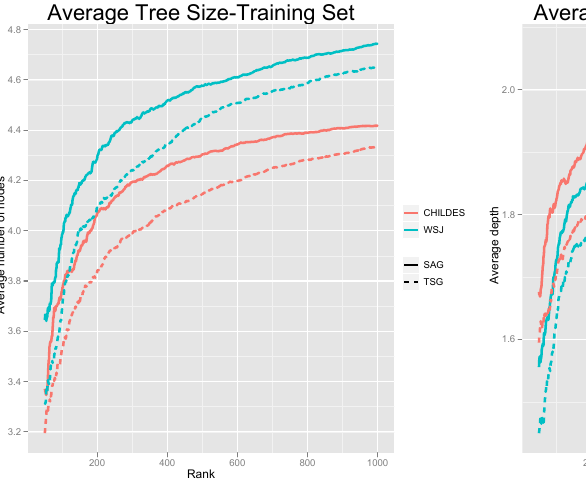
Figure 6: Complexity of stored tree fragments